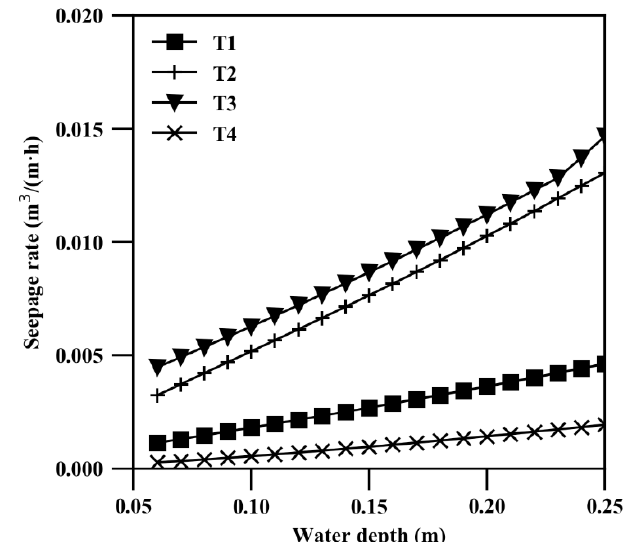
Figure 6. The canal seepage rate of four treatments. Note: The canal lining of T1, T2, T3, T4 treatment is geomembrane and concrete with a three year service time, geomembrane with a three year service time, no lining and new precast concrete slabs and new geomembrane.